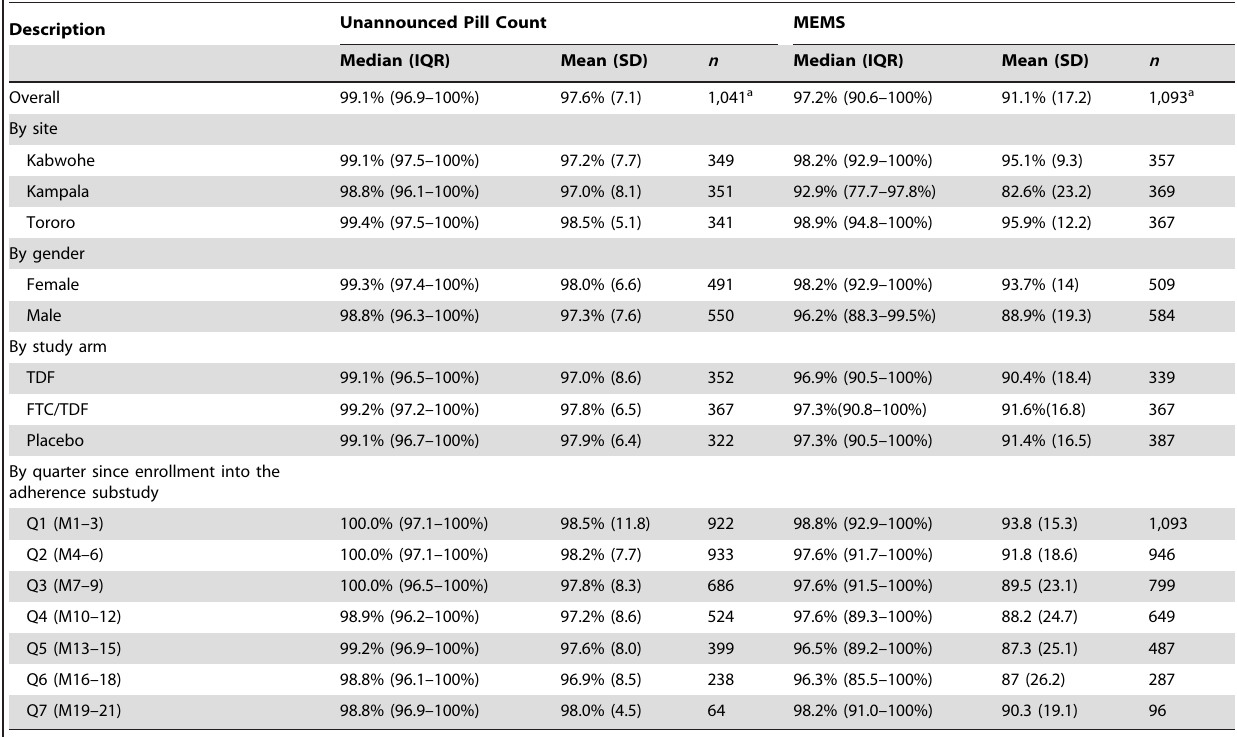
Table 2. Summary of adherence by